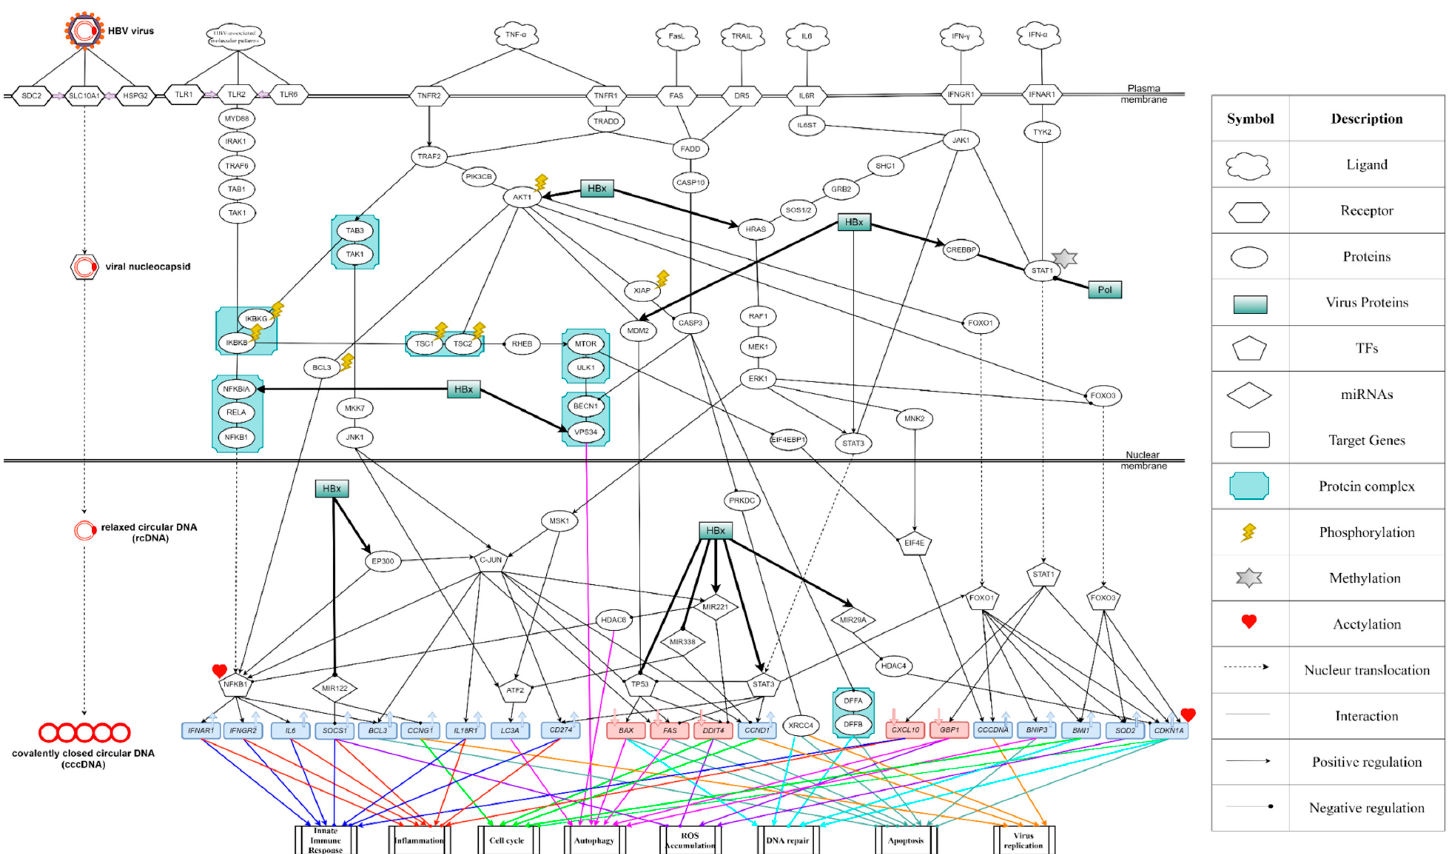
Figure 4. The core host/pathogen cross-talk signaling pathways during HBV infection. This is a network obtained from the core HPI-GEN by the annotation of KEGG (Kyoto Encyclopedia of Genes and Genomes) pathways, which represents an intracellular pathogenic mechanism during the invasion of host hepatocyte by HBV. The solid black lines indicate the regulation (with an arrowhead) and interaction between nodes. The solid lines in different colors except black represent the regulations of the corresponding cellular functions; among them, the lines with an arrowhead denote the activation of cellular functions while the lines with a circular head indicate the inhibition of cellular functions. Furthermore, for the nodes of downstream target genes, the blocks with an upward pointing arrow signify a rising expression; comparatively, the blocks with a downward pointing arrow signify a dropping expression under HBV infection.